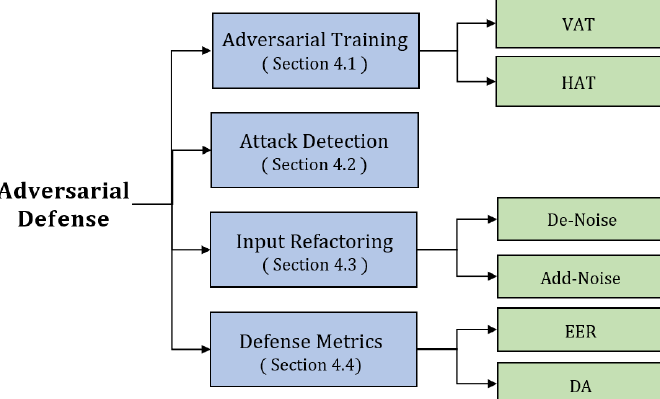
Figure 10. Taxonomy of defense methods against adversarial attacks to SRSs. Table 5. Existing defense methods against adversarial attacks to